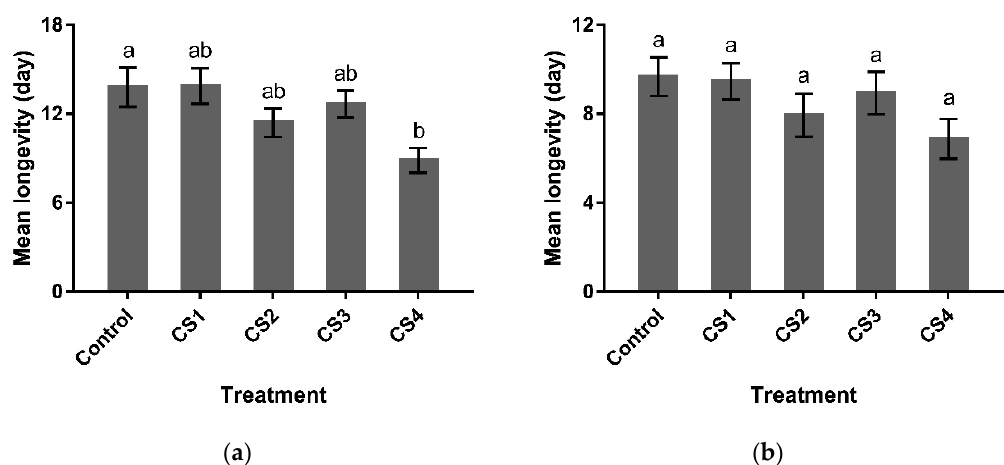
Figure 1. Longevity of G1 P. incisi post-storage females ( a ) and males ( b ) that had been subjected to different pupal cold storage treatments. CS1: cold storage 1, late-age pupae stored at 13 °C for 10 d; CS2: cold storage 2, middle-age pupae stored at 13 °C for 10 d; CS3: cold storage 3, late-age late pupae stored at 13 °C for 15 d; CS4: cold storage 4, middle-age pupae stored at 13 °C for 15 d. Control means P. incisi pupae developed at 25 °C. Bars topped with the same letter do not differ significantly ( p > 0.05) according to Tukey’s HSD test (one-way ANOVA) ( n = 15).